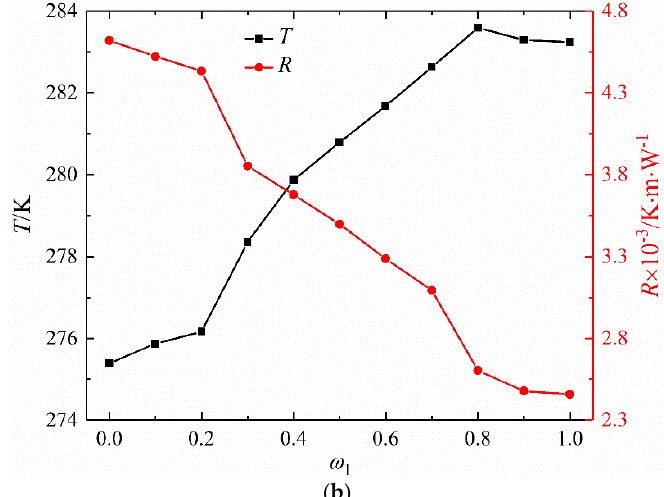
Figure 8. Variation of performance parameters under different ω 1 values. ( a ) The heat exchange J 1 and the flow energy consumption J 2 and ( b ) The average outlet temperature T and the thermal resistance R .